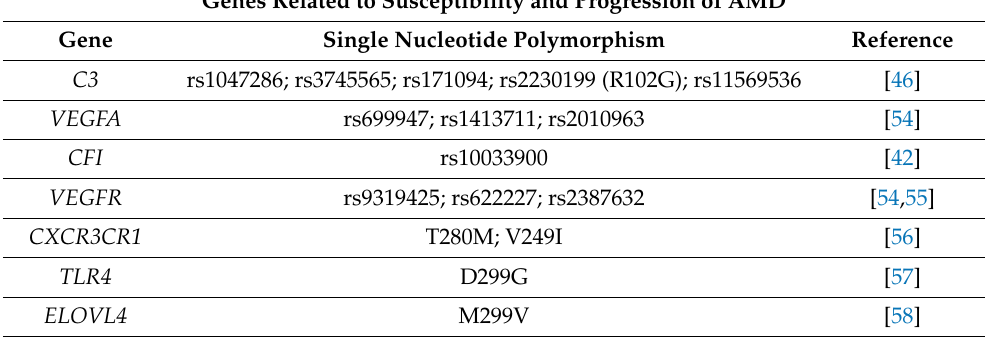
Table 1. Cont. Genes Related to Susceptibility and Progression of